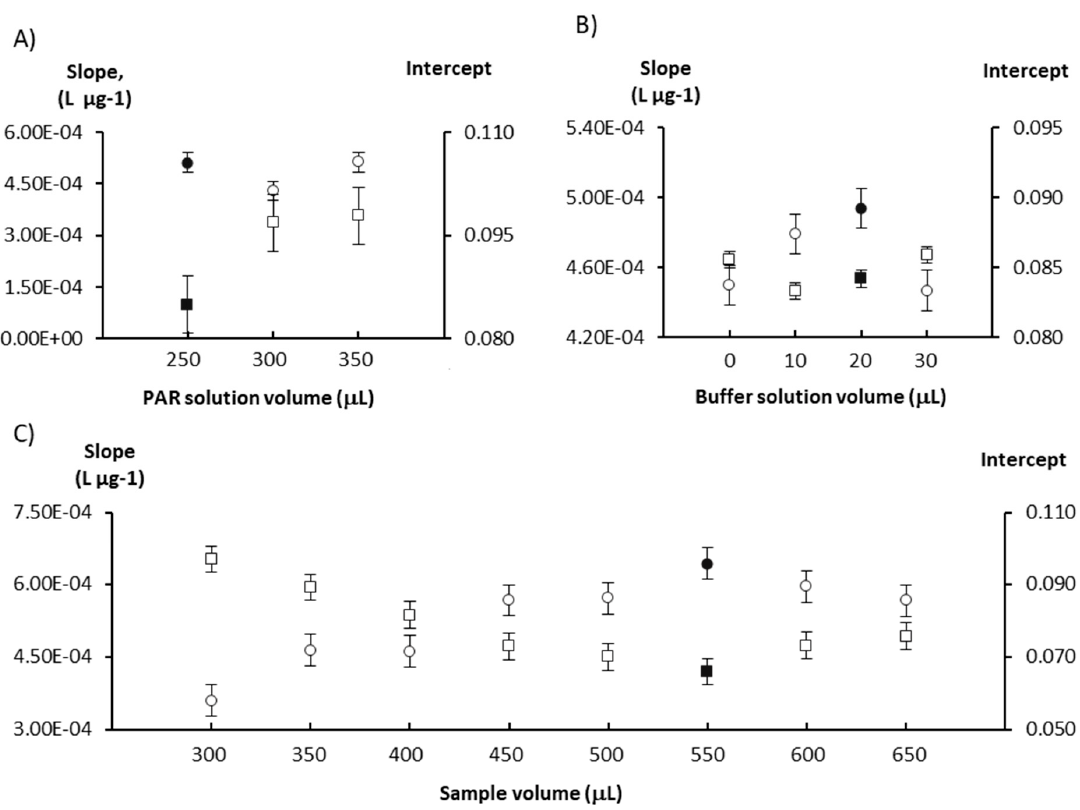
Figure 1. Study of the influence of the reagents ( A , B ) and sample ( C ) volumes on sensitivity expressed as the calibration curve slope (circles) and on the calibration curve intercept (squares). The chosen values are represented by solid-filled markers and the error bars represent the standard error.